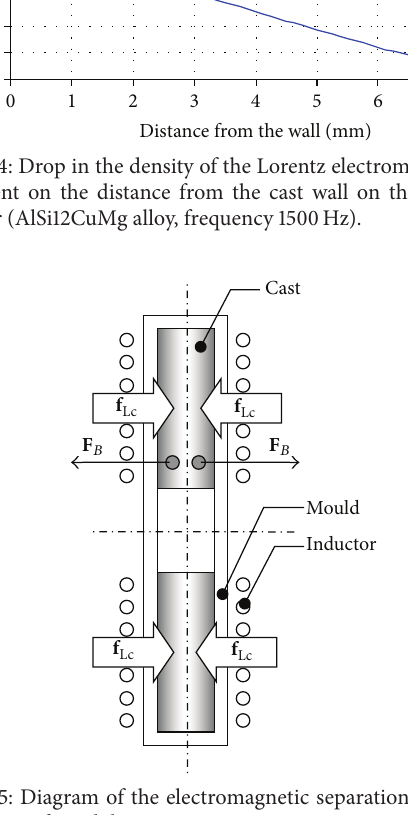
Figure 5: Diagram of the electromagnetic separation process in a two-side reinforced